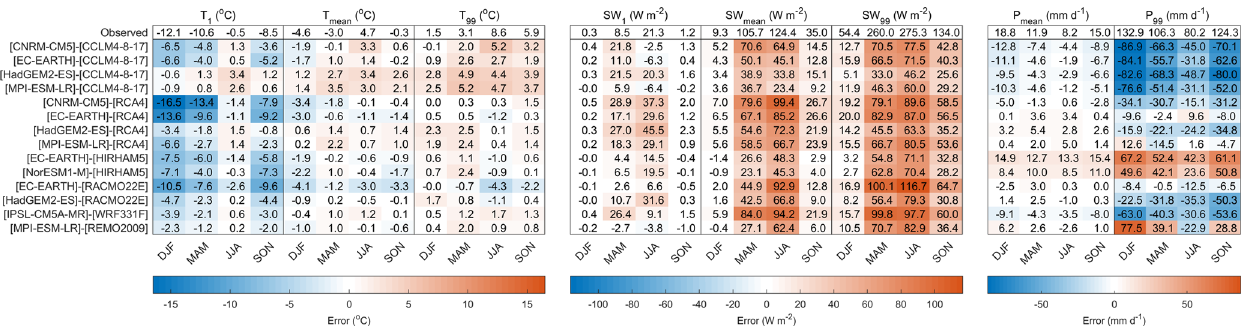
Figure 2. Comparison of seasonal catchment-average observed and simulated near-surface air temperature ( T ), incident solar radiation (SW) and total precipitation ( P ) between 1981 and 2005 for the 14 GCM–RCM models used in this study. The top row shows the observed value and all subsequent rows indicate the GCM–RCM biases. The 1st percentile, mean and 99th percentile are denoted by the subscripts 1, mean and 99 respectively. All statistics are calculated for the recent past (1981–2005) for winter (DJF), spring (MAM), summer (JJA) and autumn (SON).